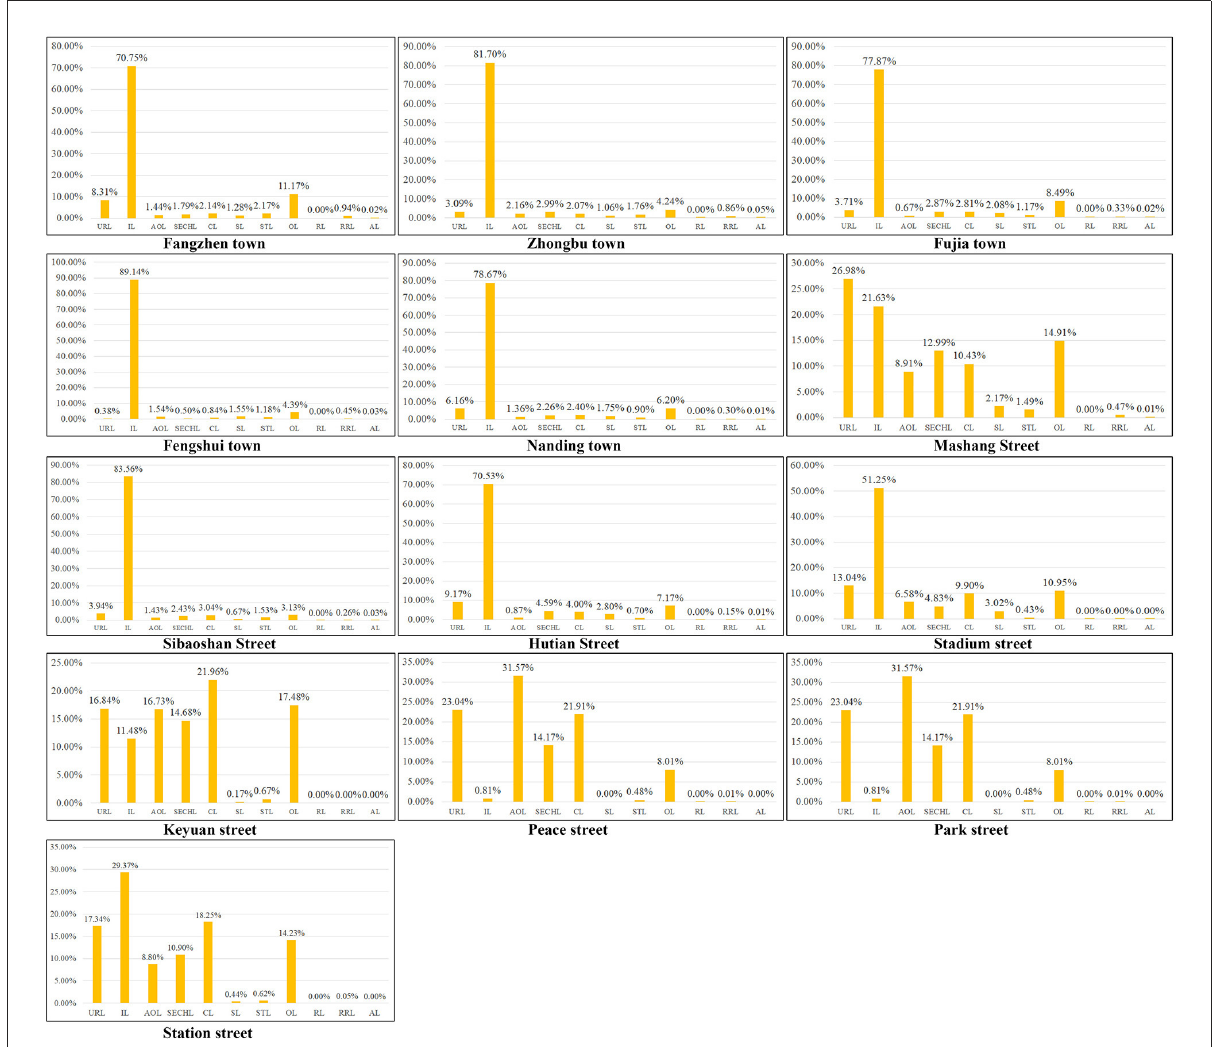
FIGURE10 Carbon emissions ratio of land patch in different streets of